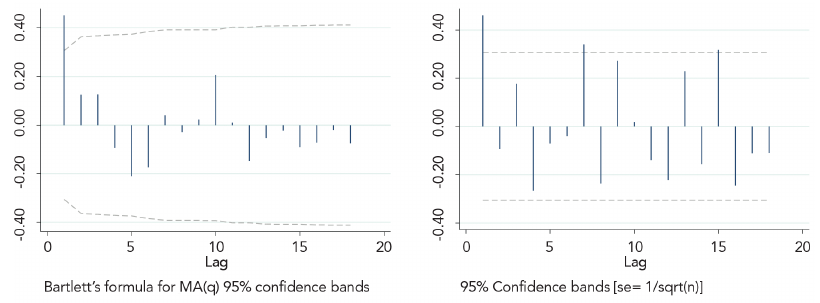
Figure 5: ACF and PACF graphs of collected mean maximum temperature